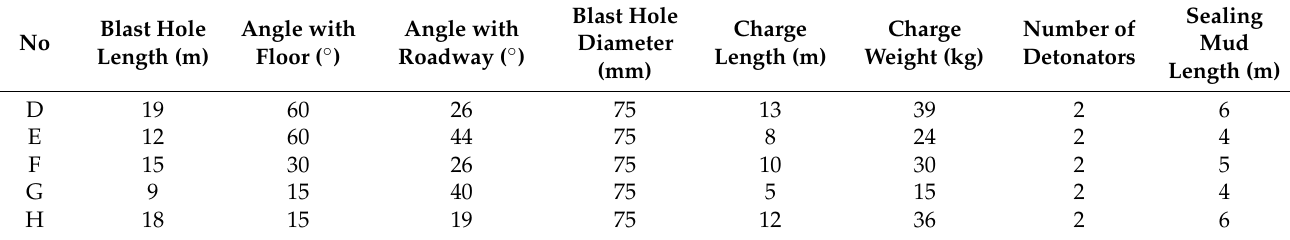
Table 3. Deep hole blasting parameters (Zone